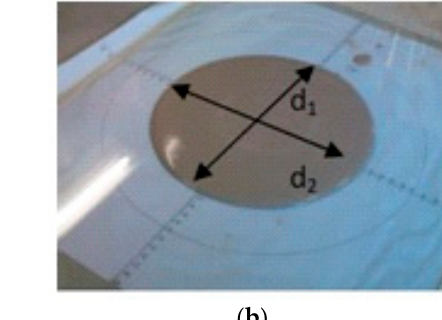
Figure 7. Slump test, ( a ) Lift the cone; ( b ) Spread sample at stoppage.